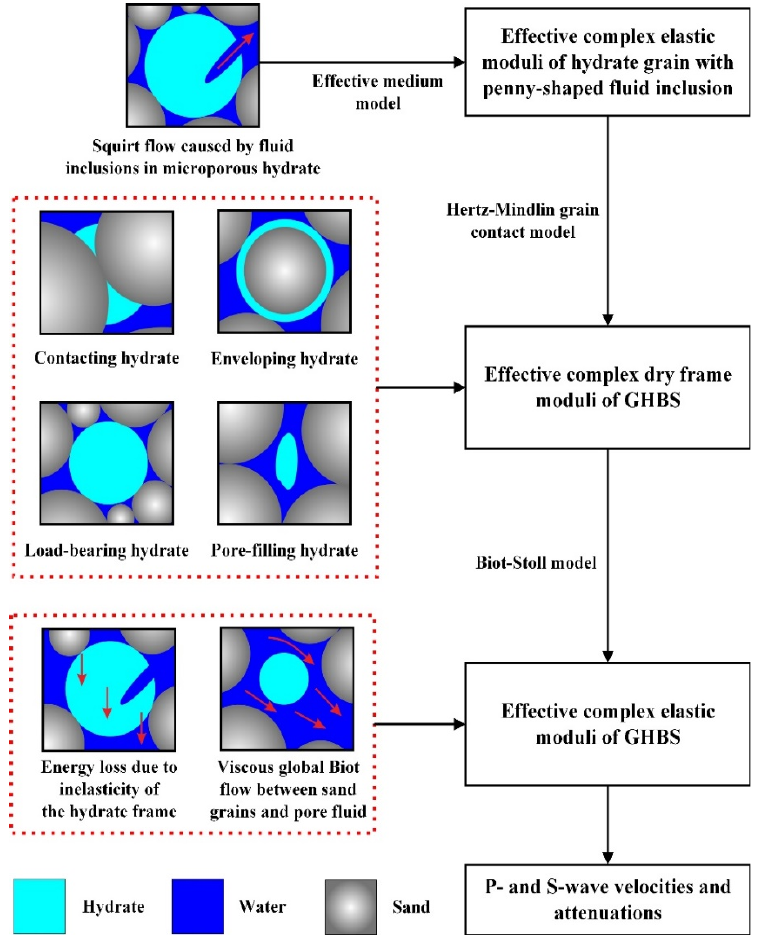
Figure 6. Workflow of the implication of the effective medium model.